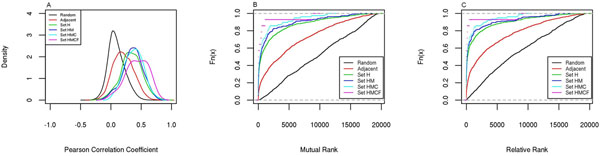
Distribution of Expression correlation indices for gene pairs from five different sets. Indices used: Pearson’s Correlation Coefficient (A), Mutual Rank (B), and Relative Rank (C). Data were from COXPRESdb.